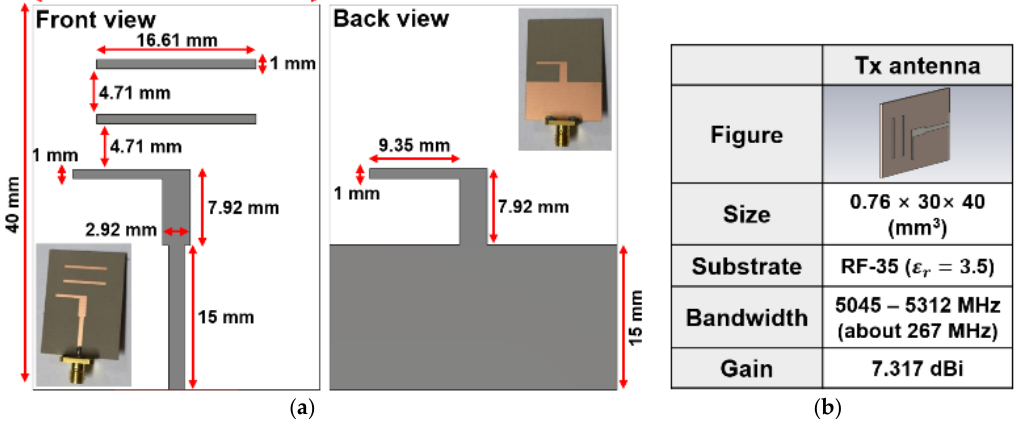
Figure 7. Configuration of the designed quasi-Yagi Tx antenna, ( a ) Front and back sides, ( b ) Specifications of the Tx antenna. Reprint with permission [4775431338148]; 2020, IEEE.